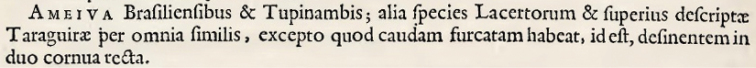
The passage related to the species Ameiva that is treated in Marcgrave (1648, p. 238). The Latin text is translated side-by-side with the English in Table 1.